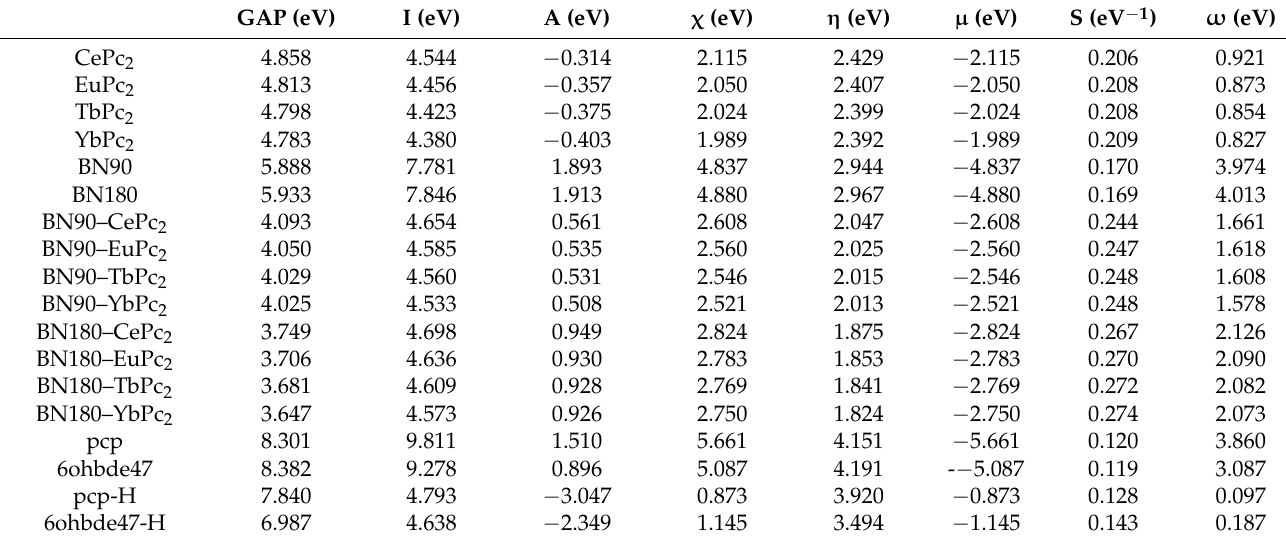
Table 2. HSAB reactivity descriptors in the present